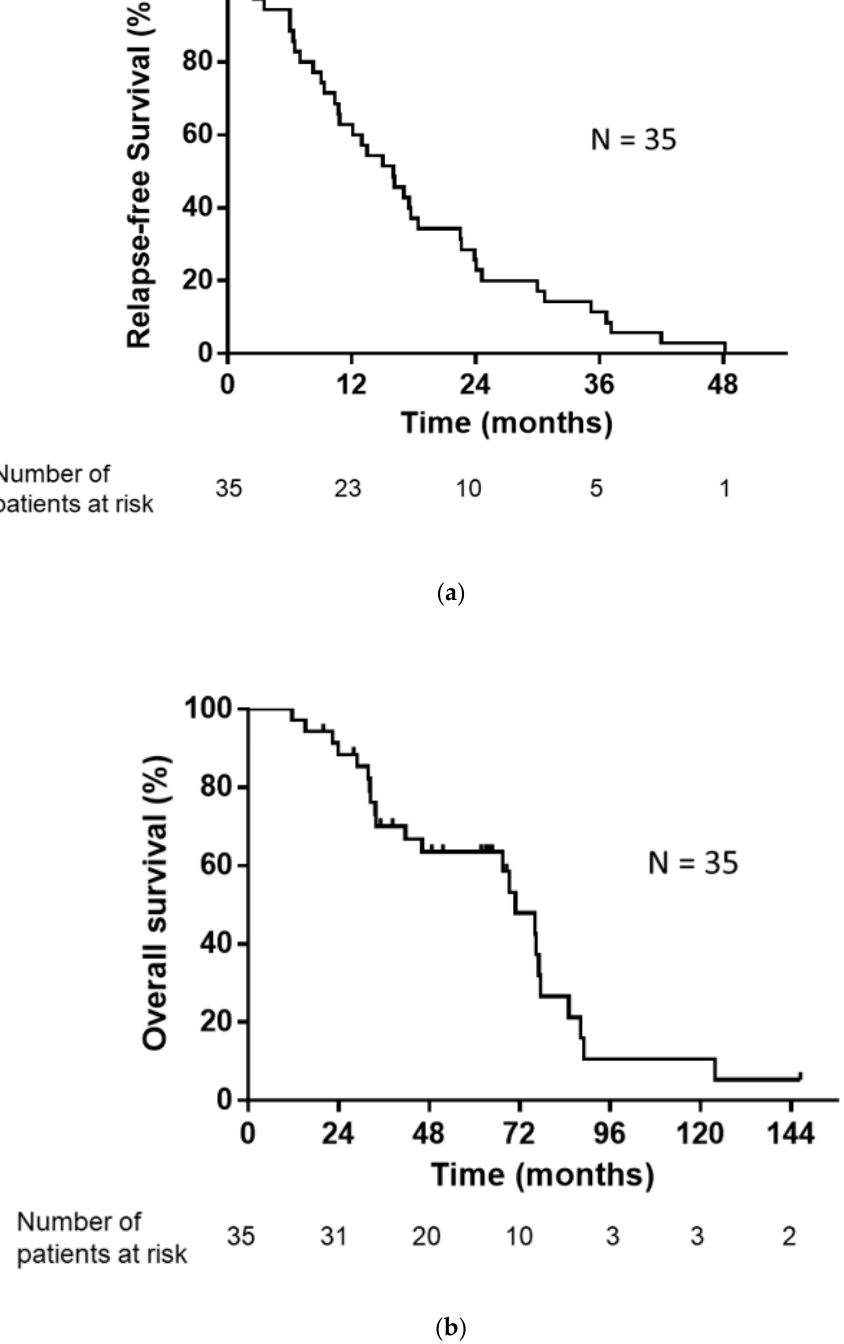
Figure 2. ( a ) Kaplan–Meier plot showing relapse-free survival (RFS). Median RFS: 16.0 months. ( b ) Kaplan–Meier plot showing overall survival (OS). Median OS: 70.9